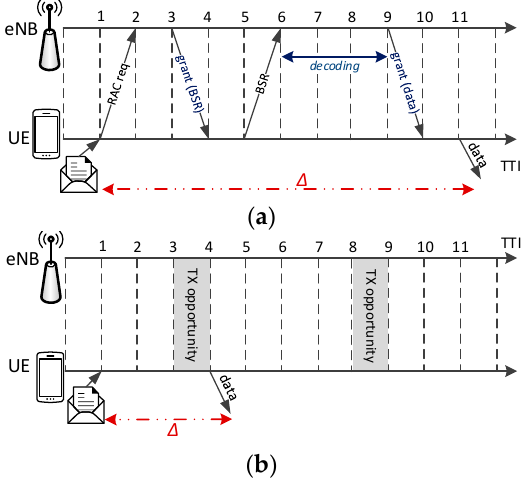
Figure 2. ( a ) Scheduled Resource Allocation (SRA); ( b ) Autonomous Resource Selection (ARS). Δ is the time between the generation of new data and the actual transmission. UE: User Equipment;